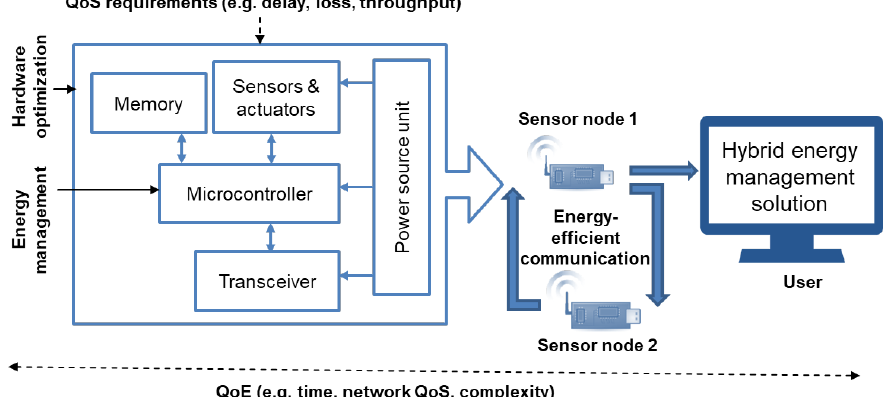
Figure 2. Proposed hybrid energy management system for ultra-low power wireless sensor node towards QoS and QoE. (Blue arrow: Connection between sensor node components, Blue filled arrow: Energy-efficient communication between sensor nodes, Black arrow: Energy-efficient techniques applied at the sensor node level, Dotted line: QoE parameter from the QoS requirements to the user